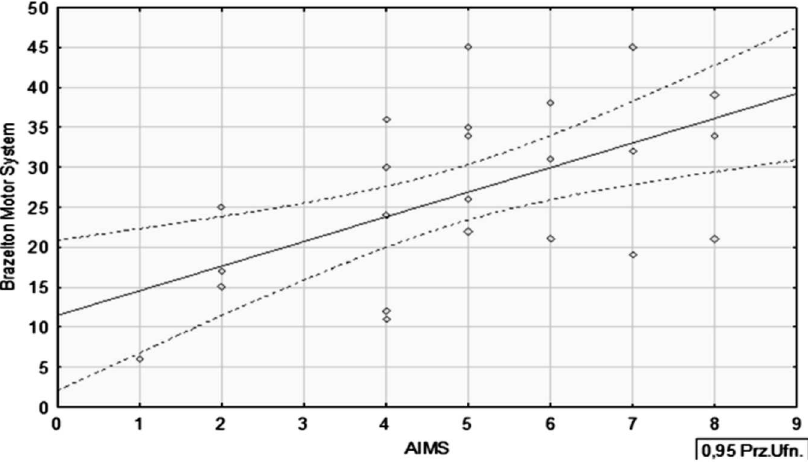
Figure 1. The Alberta Infant Motor Scale vs. the Neonatal Behavioral Assess- ment Scale (Motor System)